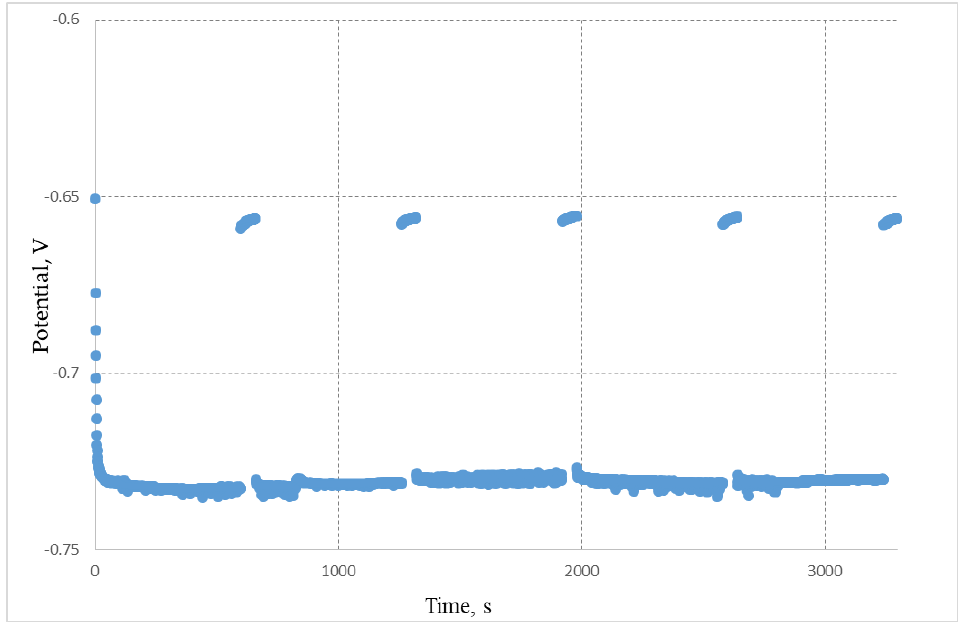
Figure 4. Change in the cathode potential during the electrolysis of the pellets composed of REM oxides in the LiCl — Li 2 O (0.5 wt.%) melt. The current of 0.3 A was passed through the melt during 600 s and then was interrupted for 60 s. The cycles were repeated. Upper curves denote the cathode potential relative to the Bi-Li reference electrode (0.658 V relative to Li + /Li) at the electrolysis current interruptions. Lower curves denote the cathode potential under the current load; 15% of the theoretical value of the electric current was passed through the melt.